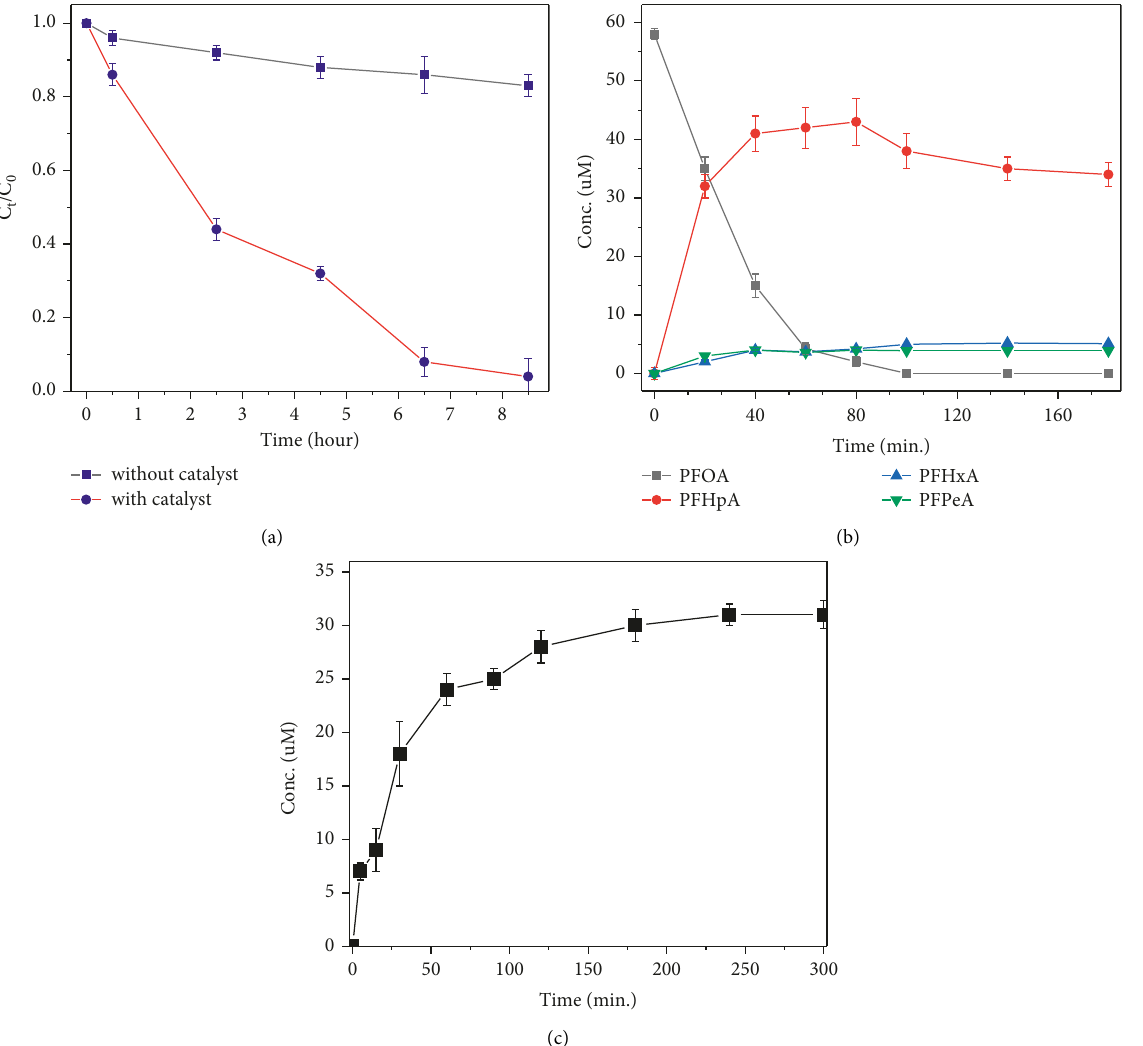
Figure 4: (a) PFOA photodegradation kinetic curves with and without TiO 2 -MWCNTand (b) degradation and product curves of PFOA in the presence of BiOI 0.8 F 2 at pH 6.0 and 25 ° C. (c) Degradation and product curves of transformed PFOA from PFOSA in the presence of 0.2M NaOH and 50mM potassium